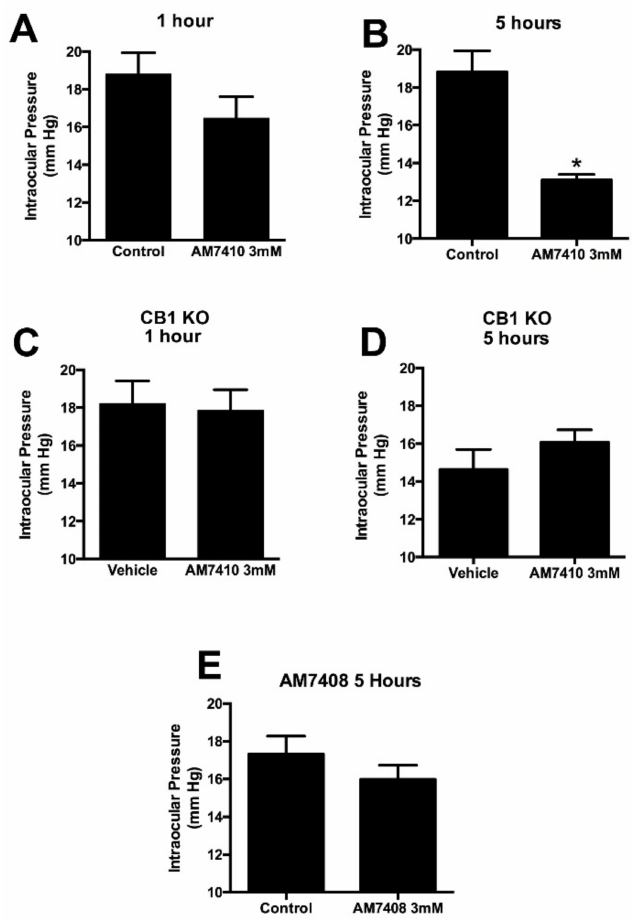
Figure 3. AM7410 lowers intraocular pressure in a normotensive model. ( A , B ) AM7410 applied topically at 3 mM lowers ocular pressure at 5 h post-treatment; ( C , D ) The effect of AM7410 on ocular pressure is absent in CB1 knockout (KO) mice; ( E ) The inactive metabolite AM7408 does not lower ocular pressure at 5 h. *, p < 0.05 by paired t